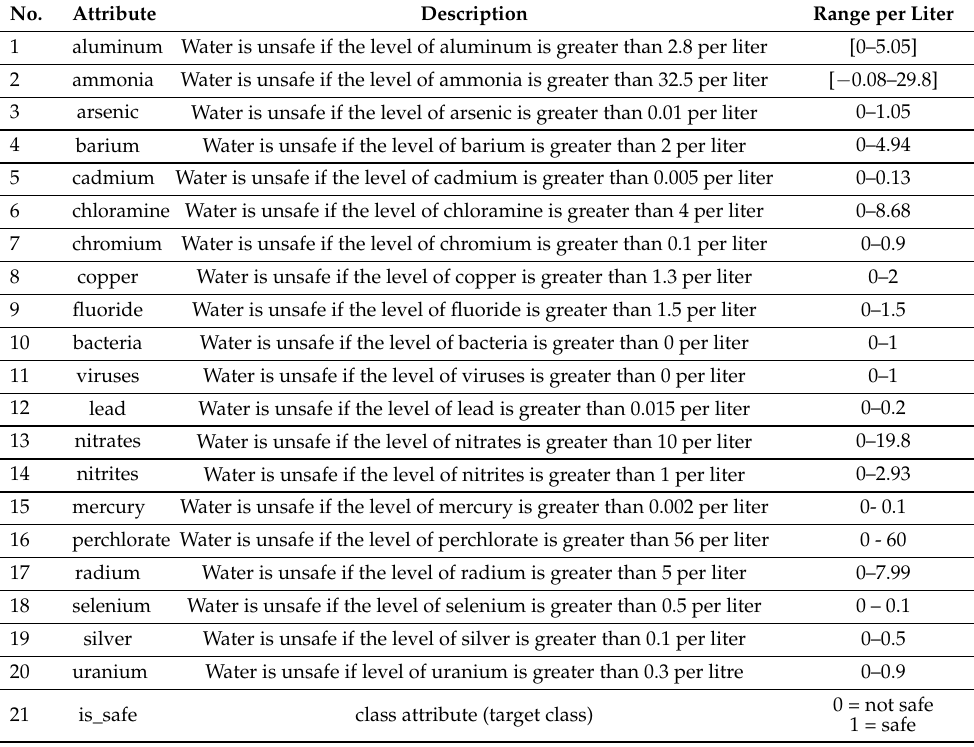
Table 2. Description of attributes of water quality